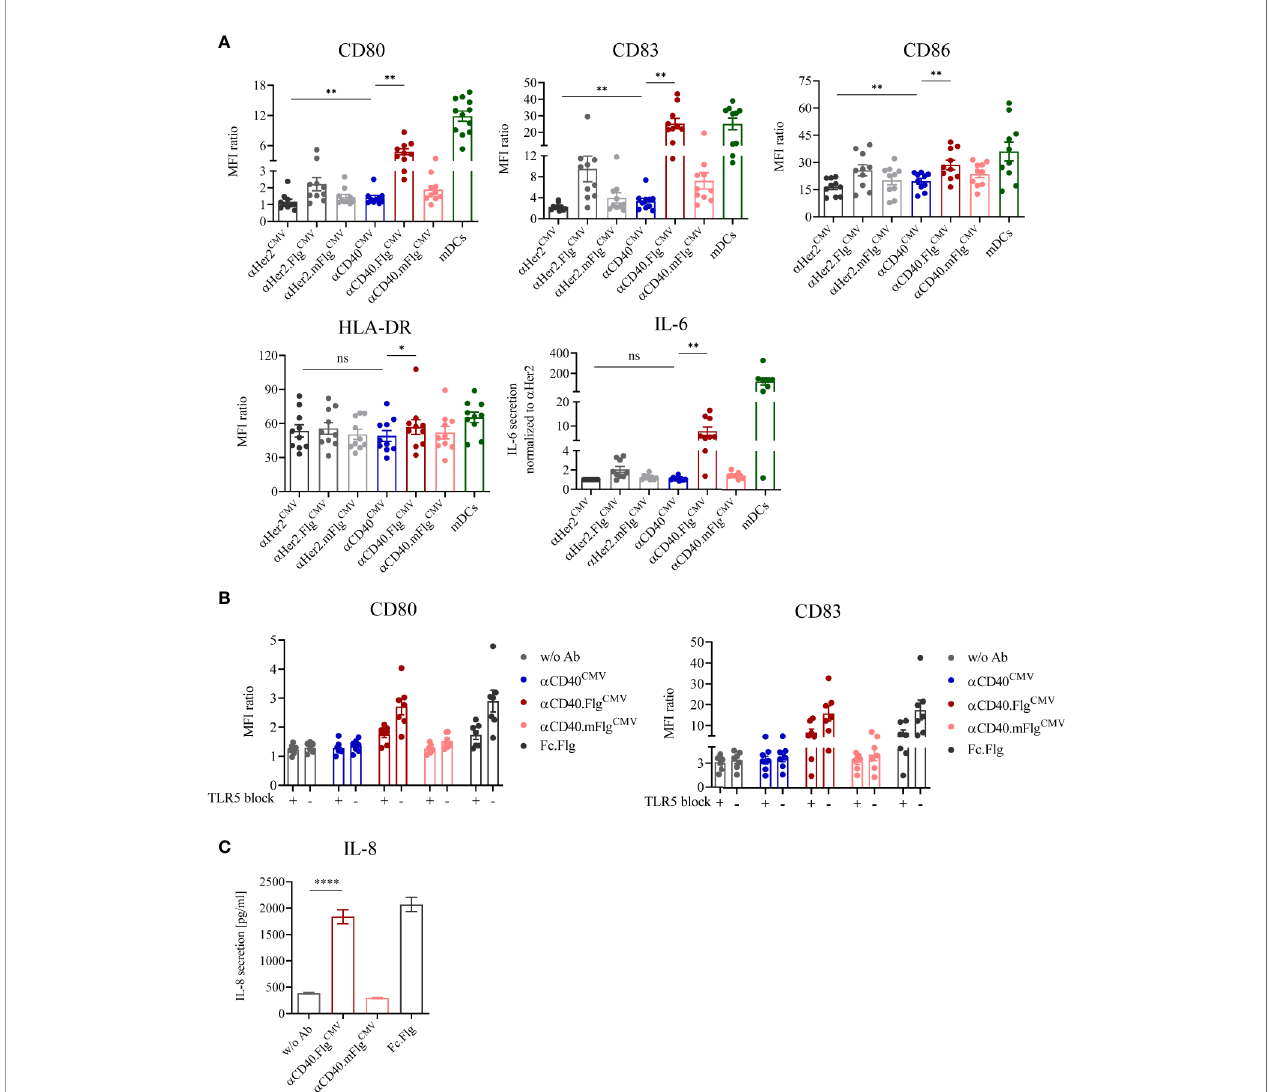
FIGURE 3 | DC maturation induced by a CD40 CMV with low intrinsic agonistic activity was signi fi cantly boosted by the fusion of bacterial fl agellin, which activates the DC speci fi cally via interaction with TLR5. (A) Expression of surface maturation markers and secretion of IL-6 by iDCs as measured by fl ow cytometry and cytometric bead array, respectively. iDCs were stimulated with a CD40 CMV , a CD40.Flg CMV , a CD40.mFlg CMV or the respective a Her2 non-speci fi c binding controls. TLR7/8-matured mDCs were included as positive controls ( n = 10 donors). (B) Expression of surface maturation markers on iDCs in combination with TLR5 blocking prior to stimulation with CD40 CMV , a CD40.Flg CMV , a CD40.mFlg CMV , Fc.Flg, or without antibody (w/o Ab) ( n = 7 donors). (C) Secretion of IL-8 by HEK293-T cells transiently transfected with hTLR5 after incubation with a CD40.Flg CMV , a CD40.mFlg CMV or Fc.Flg. The experiment was performed in biological replicates for each condition and measured in triplicates. For statistical analysis, a Wilcoxon-signed rank test (A, B) or unpaired, two-tailed Student ’ s t -test (C) were applied. Bars represent mean ± SEM. * p < 0.05, ** p < 0.01, **** p < 0.0001, ns not signi fi